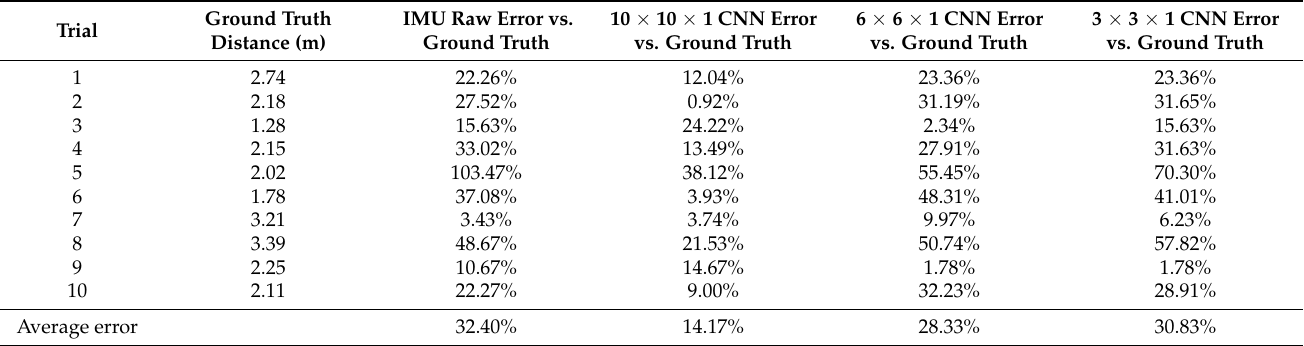
Table 6. Distance and percentage error results for EPSON IMU.